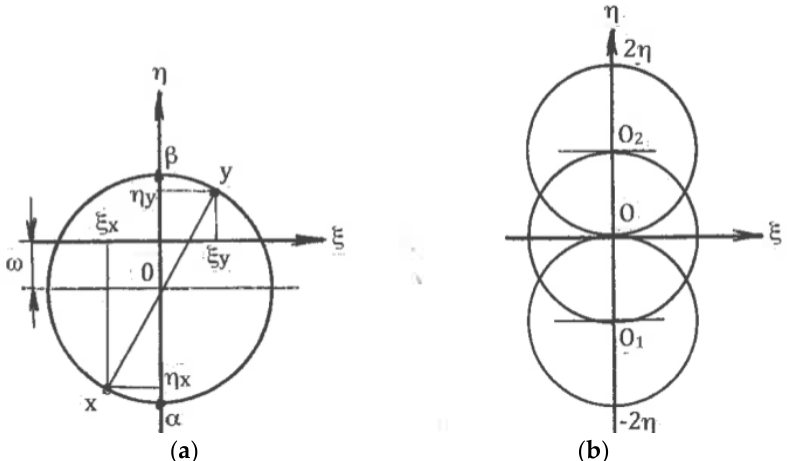
Figure 2. Moore’s circles with rotation ( a ) and in the limit cases of pure shear and simple shear ( b ).